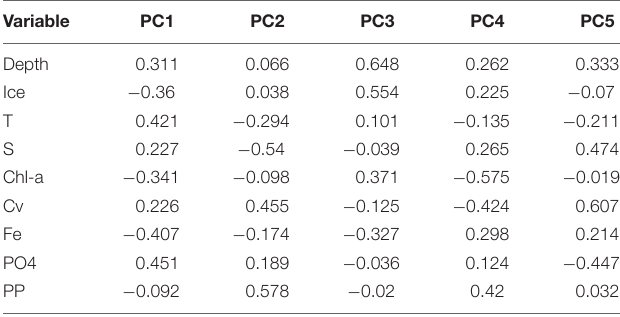
TABLE 3 | Eigenvectors for the first five principal components (PCA) from environmental